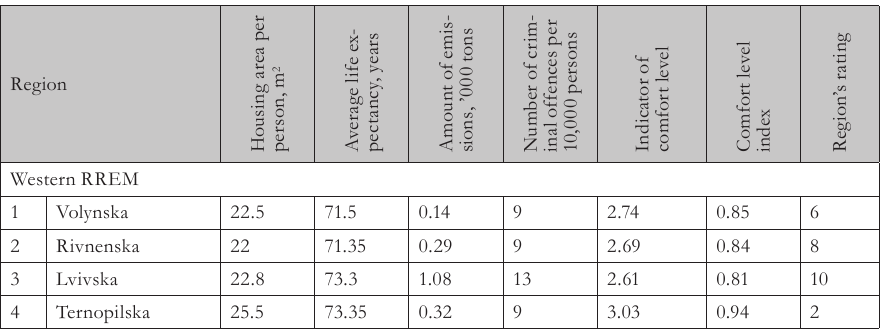
Tab. 6 – The living comfort level in Ukraine regions by their division into RREM, on January 1, 2017, (excluding the temporarily occupied territory of the Autonomous Republic of Cri- mea, the city of Sevastopol and parts of the zone of anti-terrorist operation in Donetska and Luhanska regions). Source: Ministry of Justice of Ukraine. (2019), State Statistics Service of Ukraine